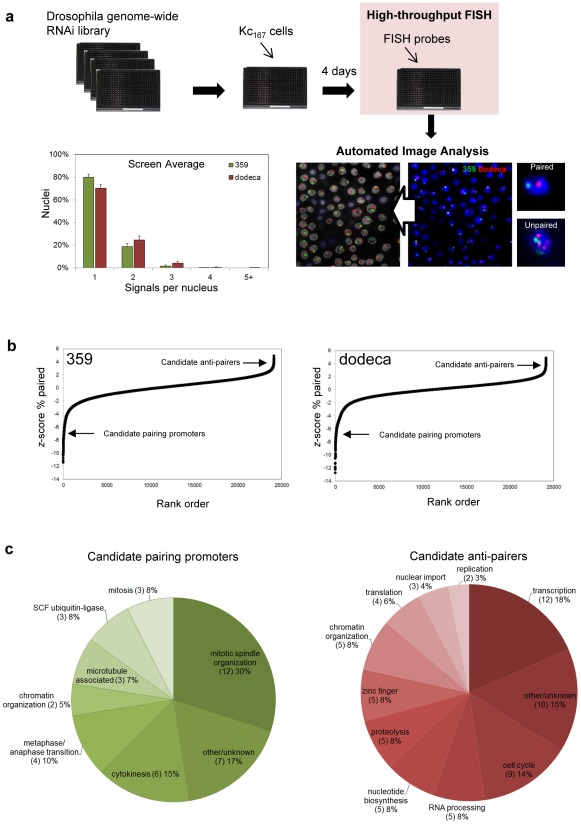
RNAi–mediated FISH–based screen of Drosophila cells for heterochromatic pairing factors.a, Experimental design with representative image before and after automated identification of nuclei and FISH signals. The screen averages for signals per nucleus obtained with probes targeting 359 and dodeca. b, Rank-order plot of each dsRNA in the primary screen, where negative z-scores indicate a reduction in paired nuclei (corresponding to candidate pairing promoters) and positive z-scores indicate an increase in paired nuclei (corresponding to candidate anti-pairers). c, Functional classifications of the candidate pairing promoters and anti-pairers.